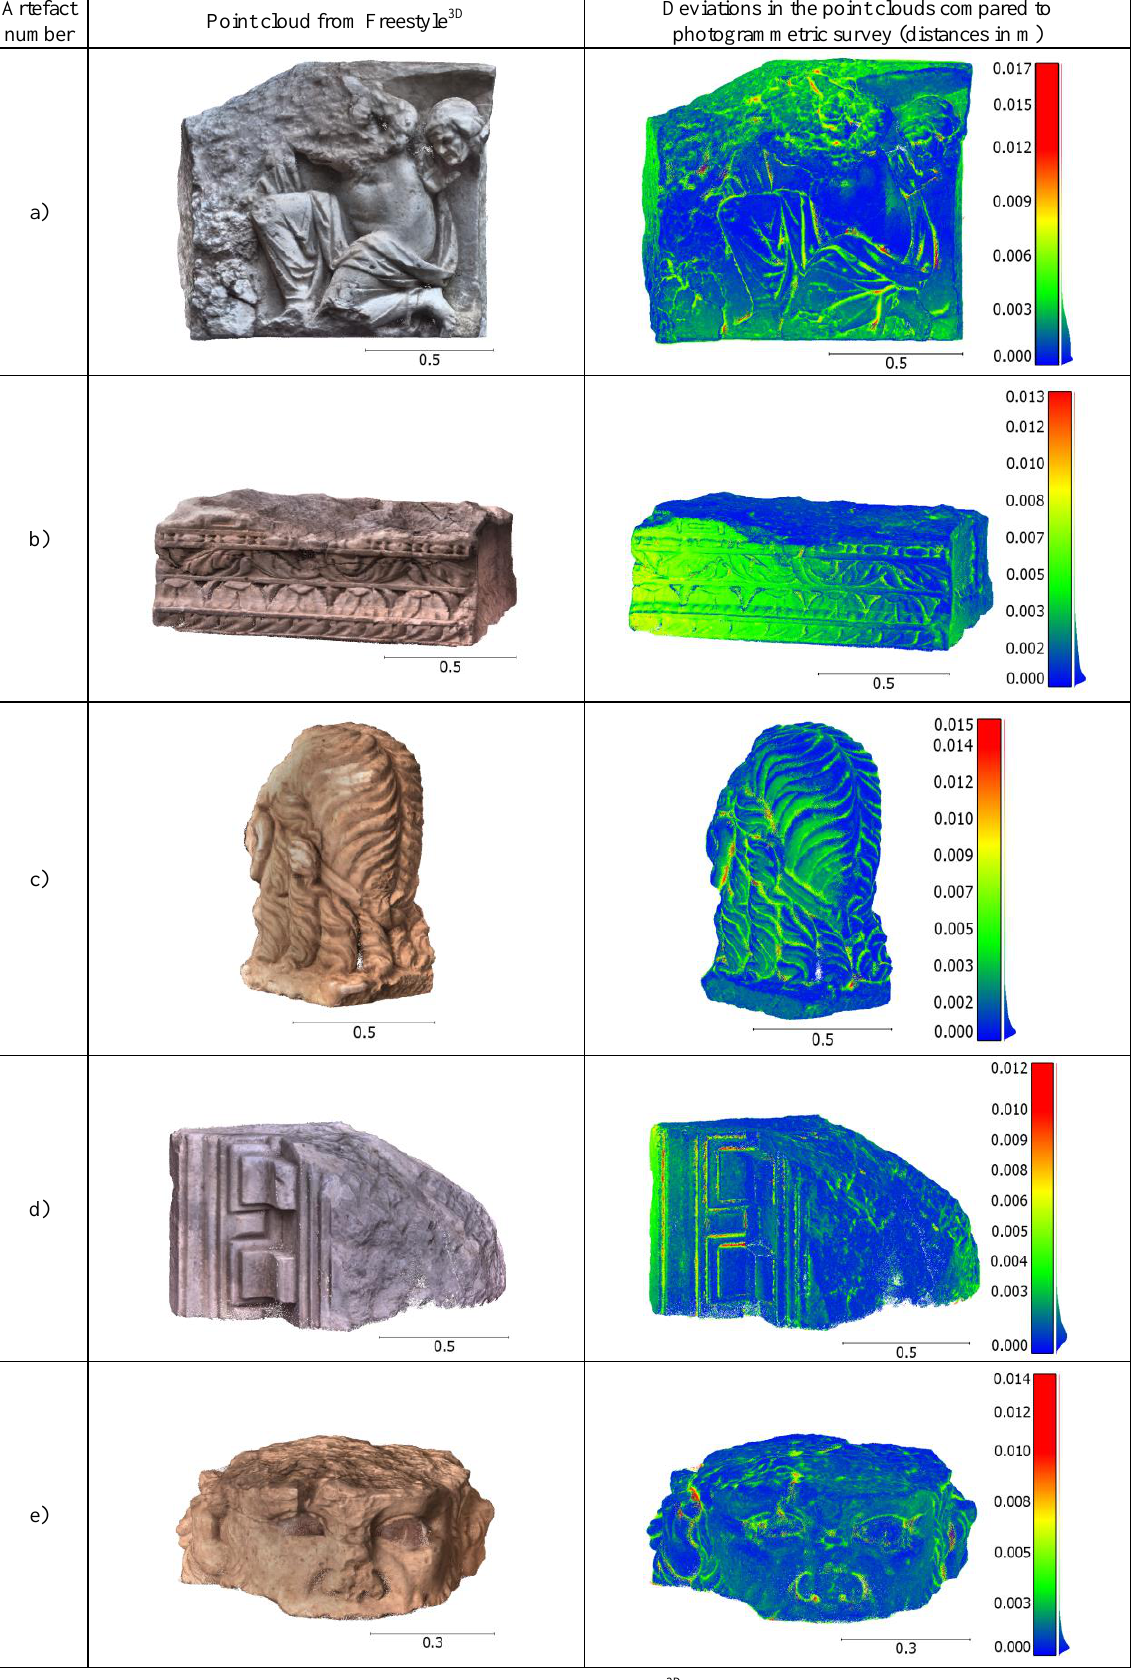
Table 9. Overview of the point clouds captured using the Freestyle 3D scanner for the five considered artefacts, and investigation of their accuracy compared to point clouds produced during the photogrammetric